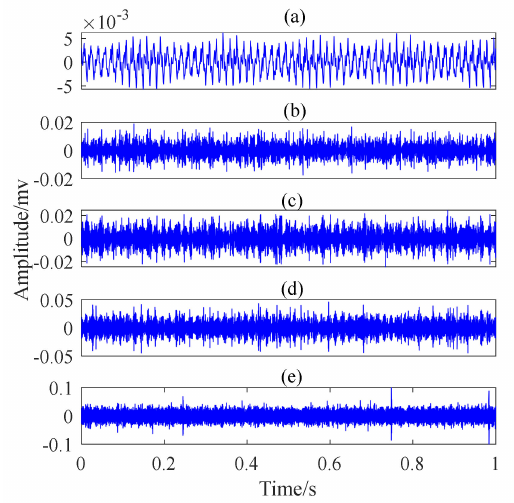
Figure 37. The IMFs of the collected signal of bearing with 3 mm inner race fault processed by the Improved EWT method: ( a ) IMF1; ( b ) IMF2; ( c ) IMF3; ( d )